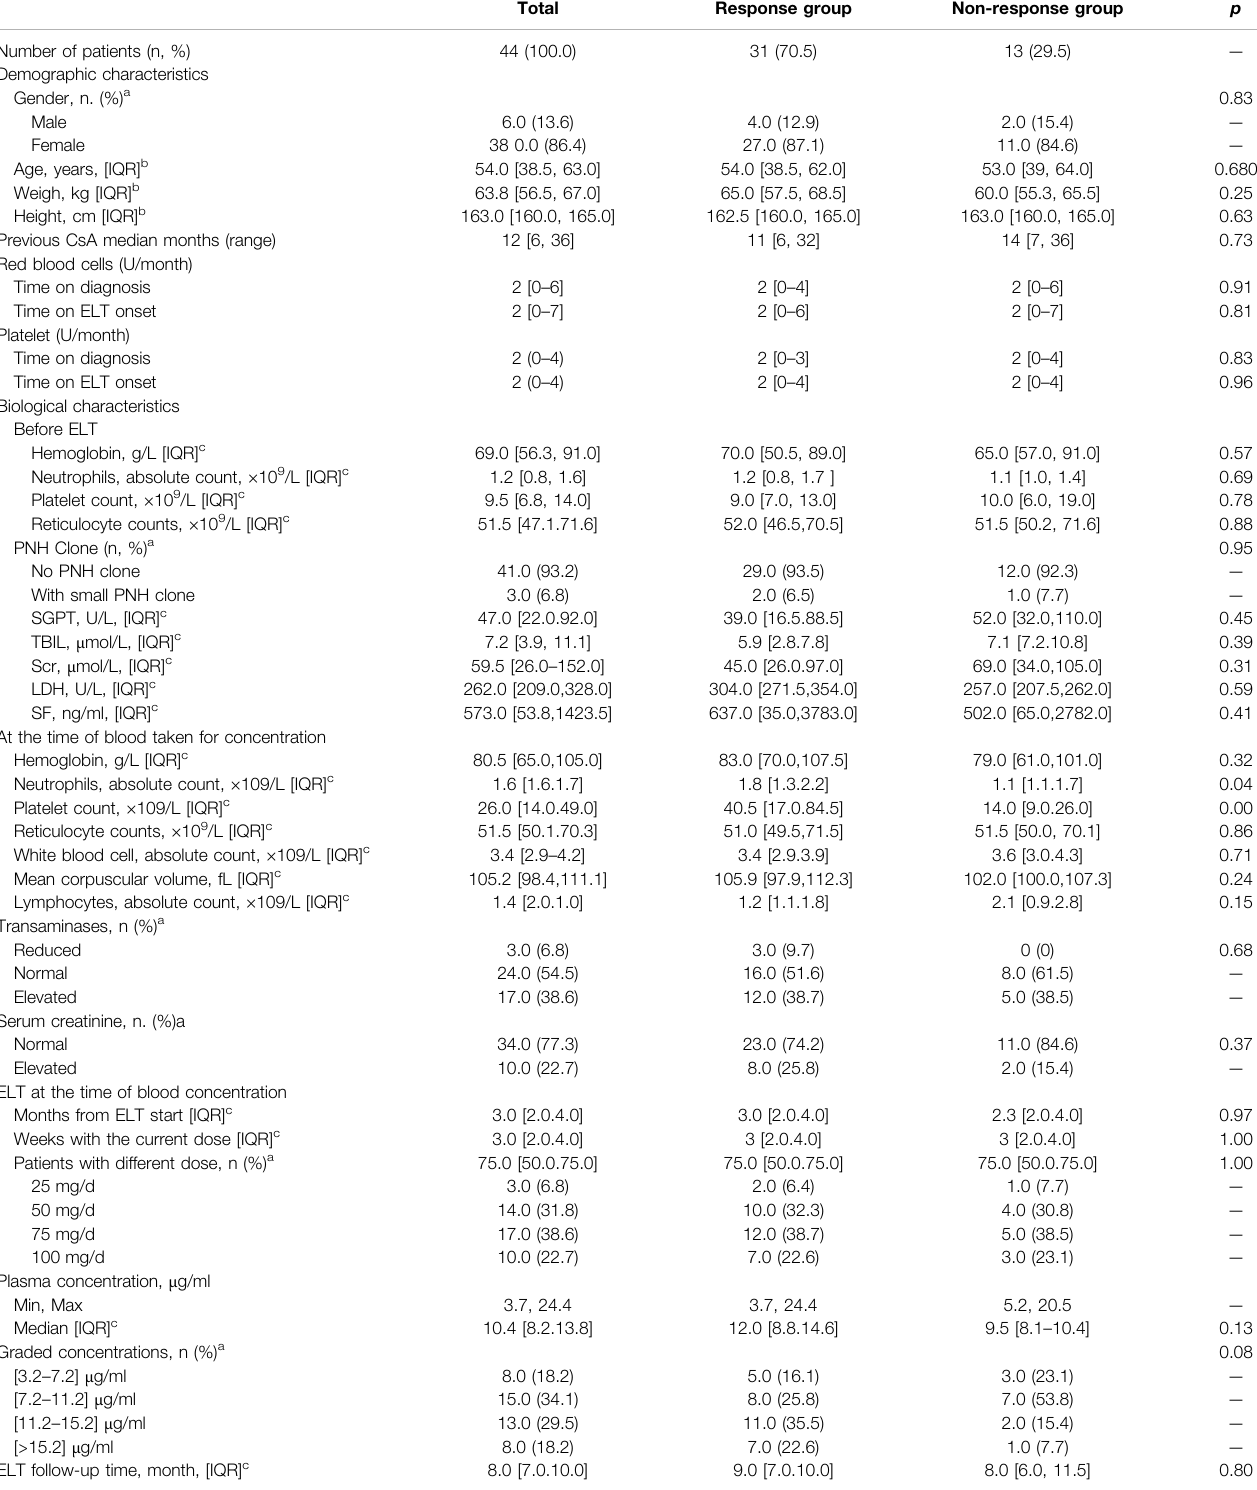
TABLE 1 | Clinical characteristics of the patients